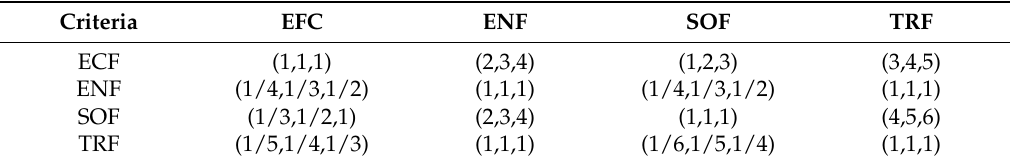
Table 6. Fuzzy comparison matrices for